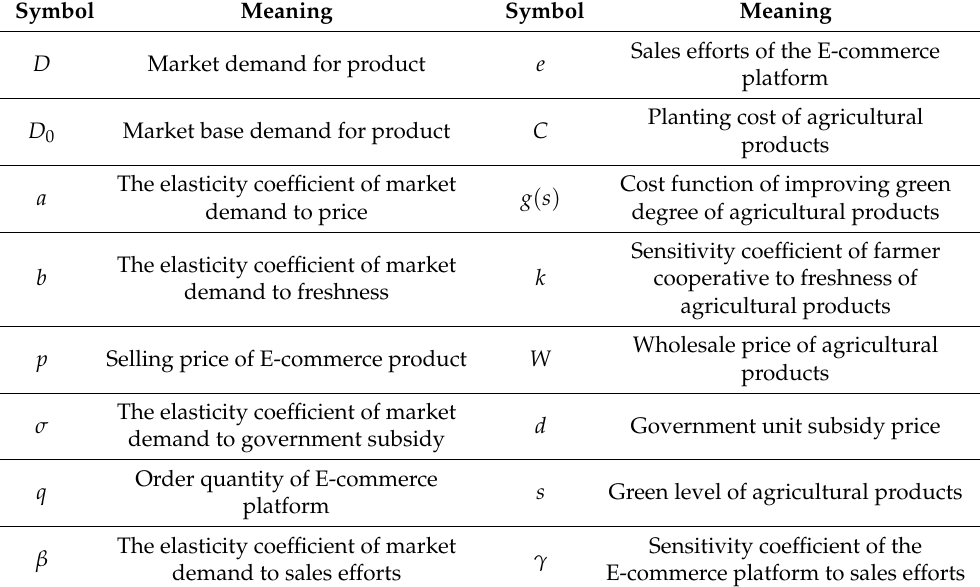
Table 1. Research model symbols and